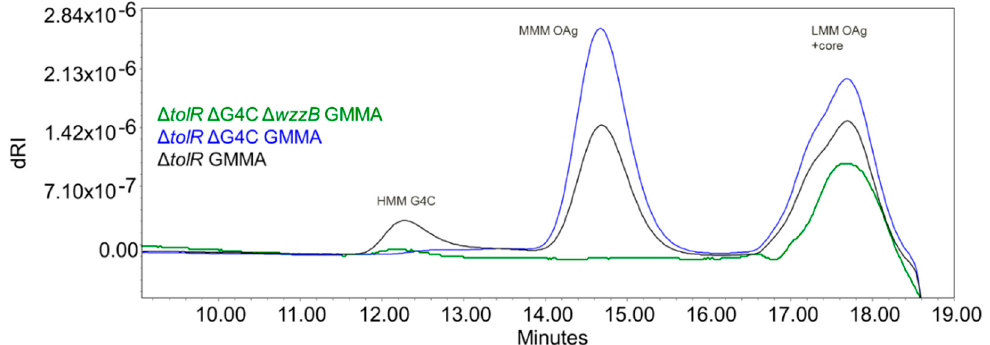
Figure 6. HPLC–SEC dRI profiles of sugar extracted from S. flexneri 6 ∆ tolR (black), ∆ tolR ∆ G4C (blue), and ∆ tolR ∆ G4C ∆ wzzB (green) GMMA. Table 5. Main characteristics of GMMA differing in sugar length.